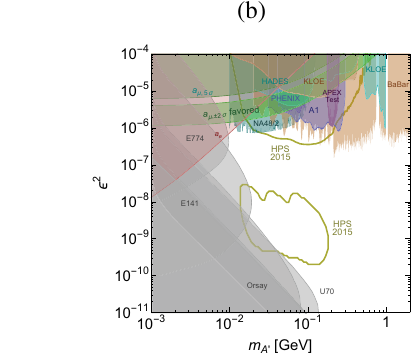
Figure3. TheHPSprojectedreachcorrespondingtothe2 σ limit (yellowline). Thegreenband a μ ± 2 σ ( a μ ± 2 σ )correspondstothe regionwherethe A (cid:2) canexplainthediscrepancybetweentheex- perimentalvalueofthemuonanomalousmagneticmoment,con- sideringa2 σ (5 σ )error,andthecorrespondingStandardModel calculation.